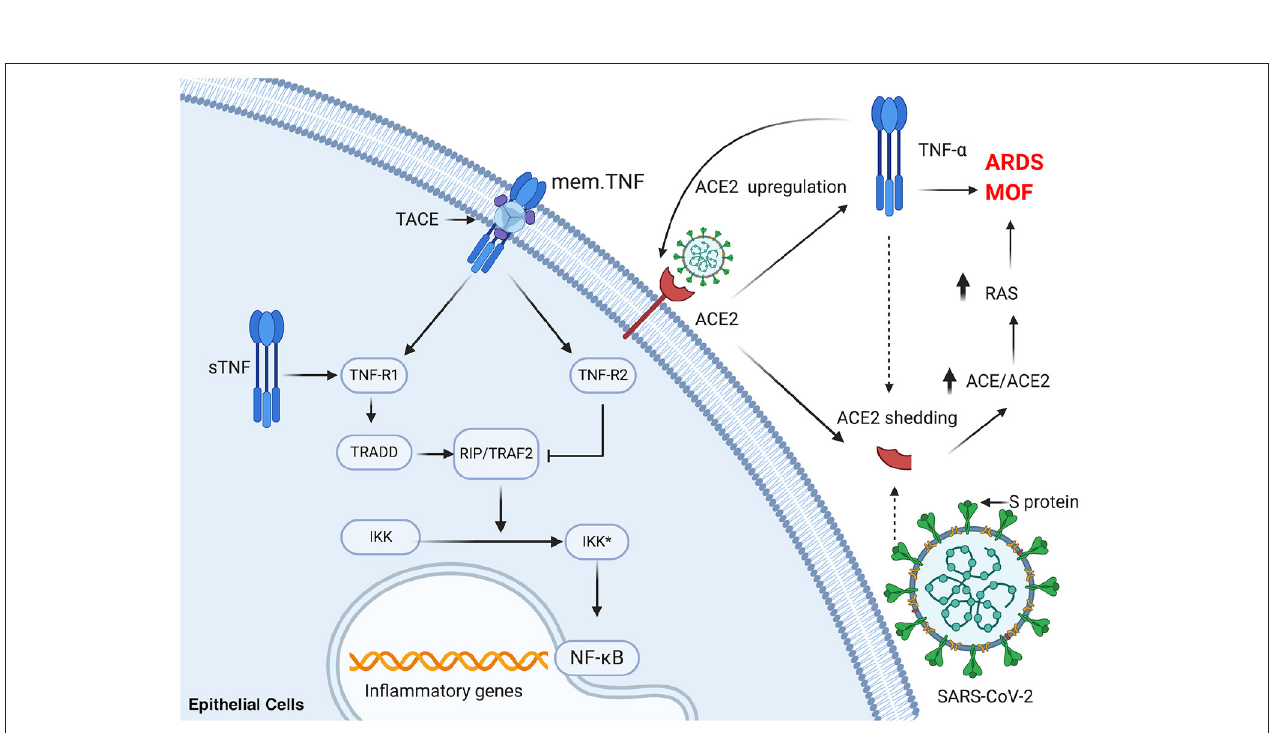
FIGURE 2 | TNF-a plays a significant role in activation of NF- κ B and ACE2 shedding in SARS-CoV-2 infection. mem.TNF, membrane-bound TNF; sTNF, soluble TNF; TACE, TNF- α -converting enzyme; TNF-R1, TNF-receptor 1; TNF-R2, TNF-receptor 2; TRADD, TNF-receptor-associated protein; RIP, receptor-interacting protein; TRAF2, TNF receptor-associated factor 2; IKK, I- κ B kinase; NF- κ B, nuclear factor kappa B; ACE, angiotensin-converting enzyme; ARDS, acute respiratory distress syndrome; MOF, multi-organ failure; RAS, renin-angiotensin system. This figure was generated in Biorender (https://Biorender.com).